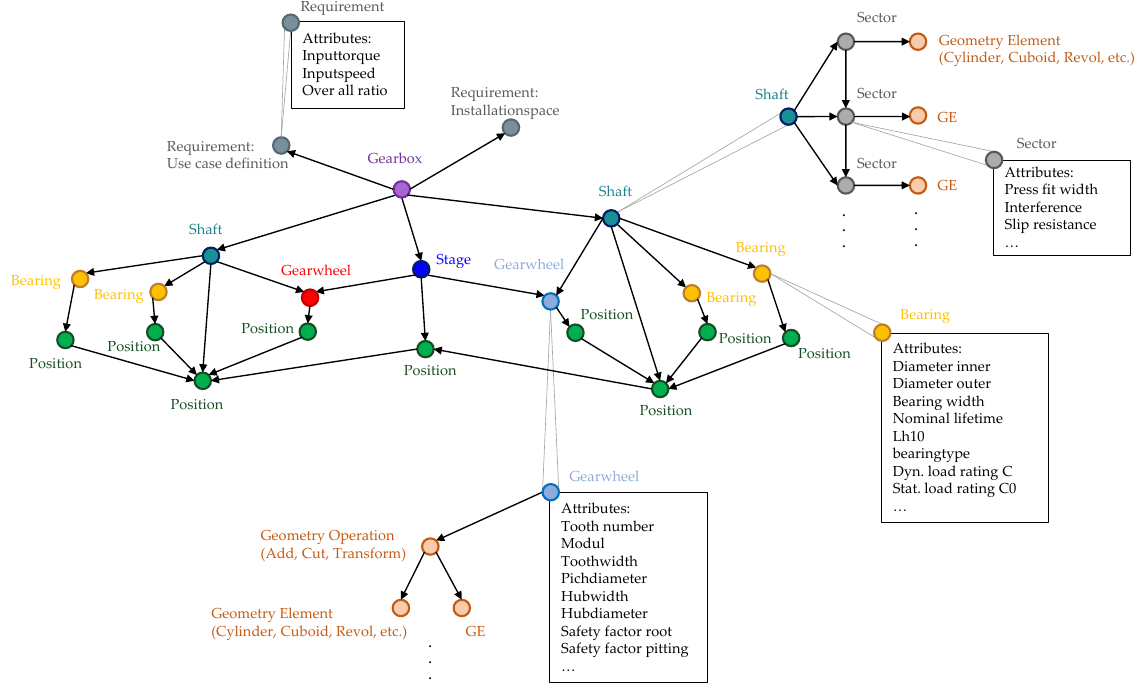
Figure 13. Design graph as a central data model for the drive